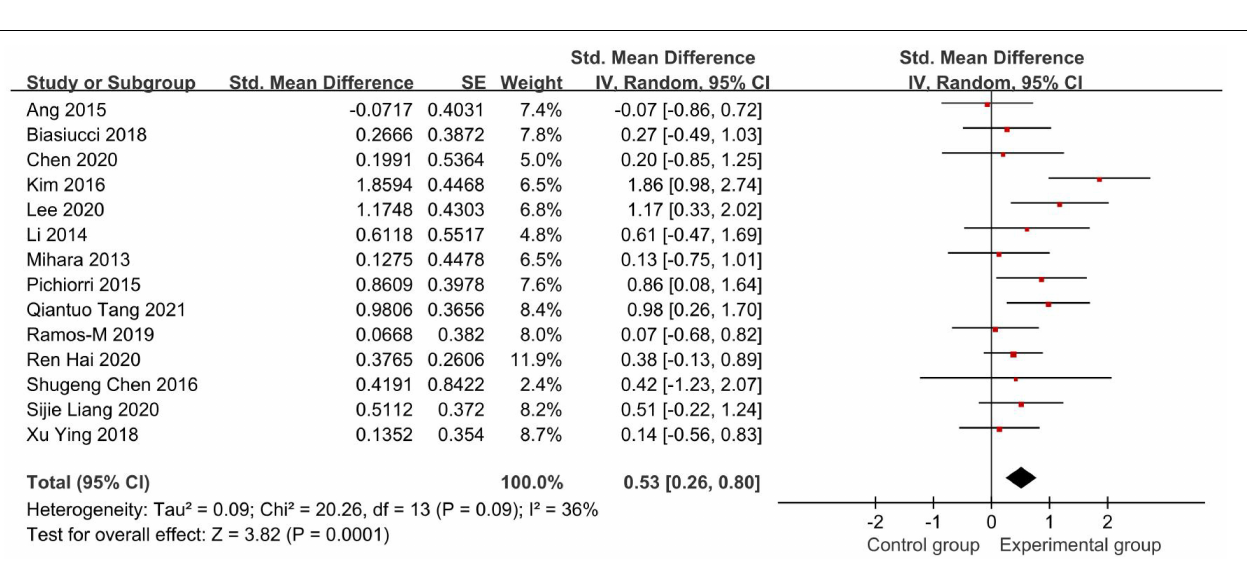
FIGURE 4 | Forest plot of the Fugl-Meyer Assessment (FMA) score to evaluate the effect of brain-computer interface (BCI) on upper limb dysfunction after stroke.